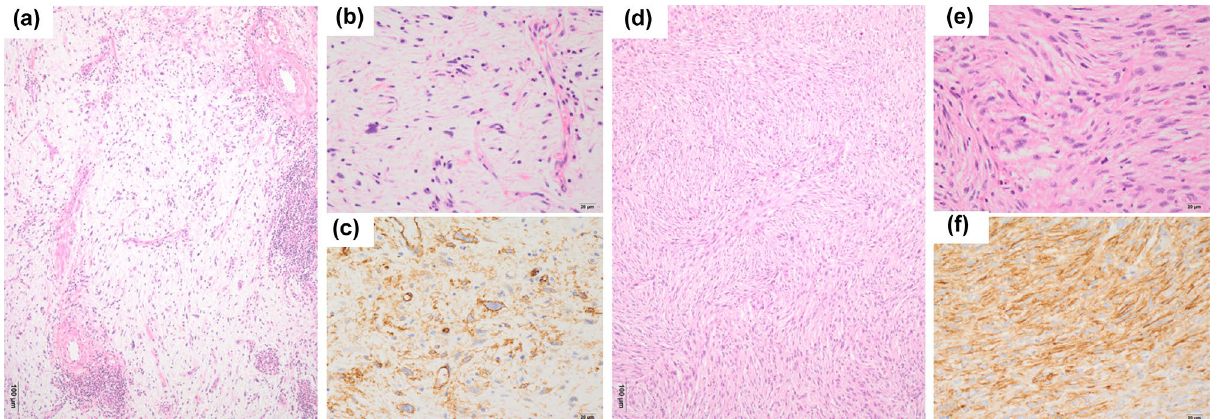
Figure 1. Histology and CD34-immunostaining of myxofibrosarcoma (MFS) and undifferentiated pleomorphic sarcoma (UPS). ( a and b ) MFS: Pleomorphic sarcoma with myxoid stroma (hematoxylin and eosin stain; original magnification, ×40 in A and ×400 in B. ( c ) MFS: The cytoplasm and cell membrane are strongly positive for CD34 (immunostaining, original magnification, ×400). ( d and e ) UPS: Pleomorphic sarcoma with non-myxoid stroma (hematoxylin and eosin stain; original magnification, ×40 in d and ×400 in e ). ( f ) UPS: The cytoplasm and cell membrane are strongly positive for CD34 (immunostaining, original magnification,